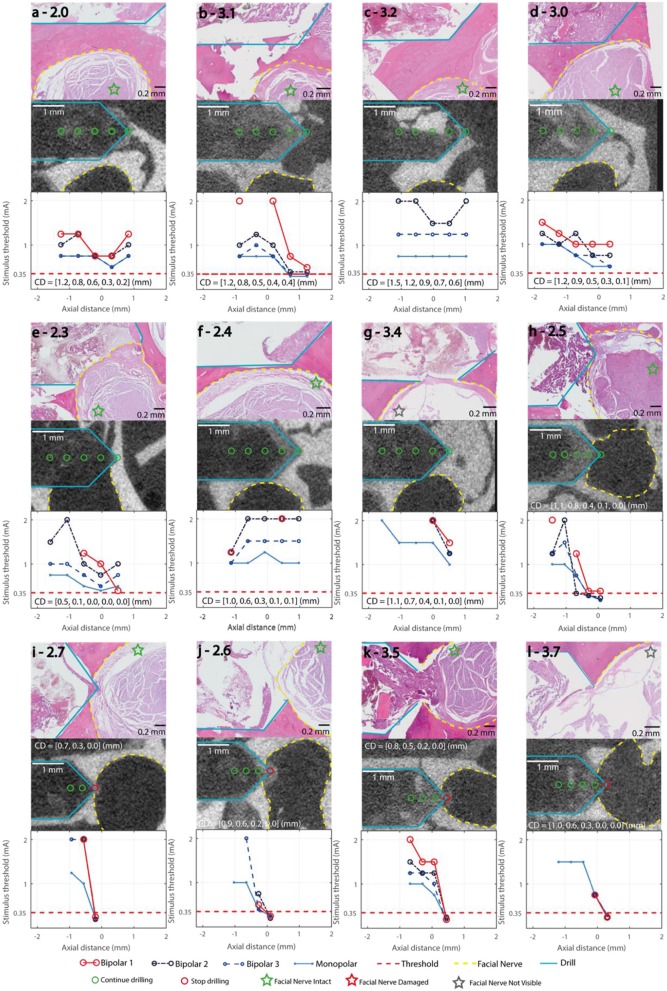
Stimulation Thresholds of the FNM (bottom row), with the decision thresholds and the decisive electrode configuration marked in red, bipolar 2,3 and monopolar (blue). μCT (middle row), drill (turquois), measurement points marked green/red (go/stop) depending on the FNM assessment, facial nerve (yellow). CD: closest distance between drill and facial nerve in mm in each measurement point. Histology (top row) with H&E staining, Facial nerve assessment marked with a star. (a–c) Lateral trajectories with FN distance ≥ 0.2 mm; (d–g) Lateral trajectories with FN distance ≤ 0.1 mm; (h–l) Frontal trajectories with FN distance ≤ 0.1 mm.